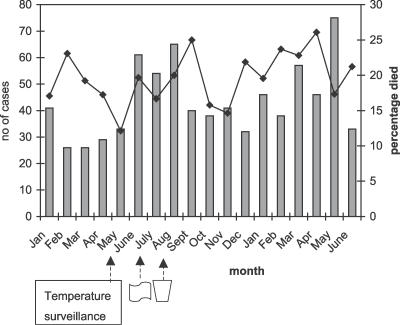
Monthly Admission of Children with Severe Malnutrition (Bars) and Percentage Case Fatality (Line) for 2001–2002In July 2001, during a period of 6-h temperature surveillance, the routine prescription of a blanket (see blanket symbol) was added to the treatment chart, and in August 2001 (see cup symbol), F75 and F100 were prepared (day and night) in a specifically devoted “milk kitchen” with dedicated trained workers to expressly supply the malnourished with warm milk feeds every 4 h, or as required.